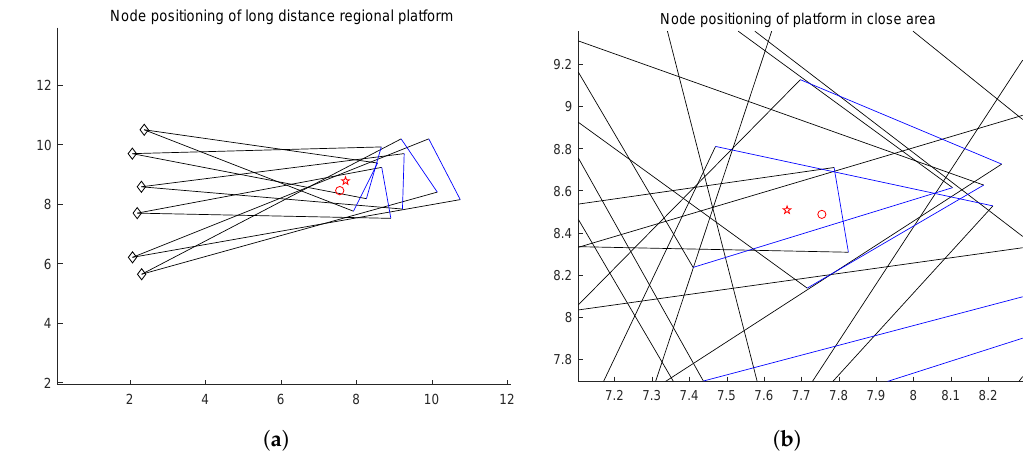
Figure 15. ( a ) is the positioning simulation of the platform node when the communication range is far; ( b ) is the simulation precision display. ( ☆ is the positioning position of the platform to the node, and ◯ is the actual position of the